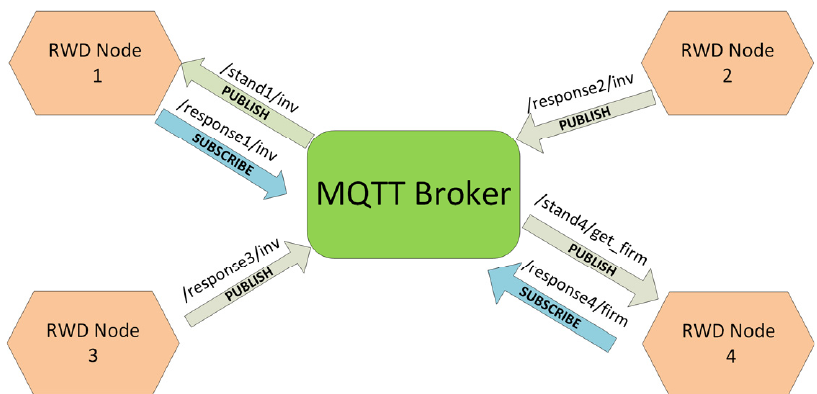
Figure 2. Idea of MQTT.